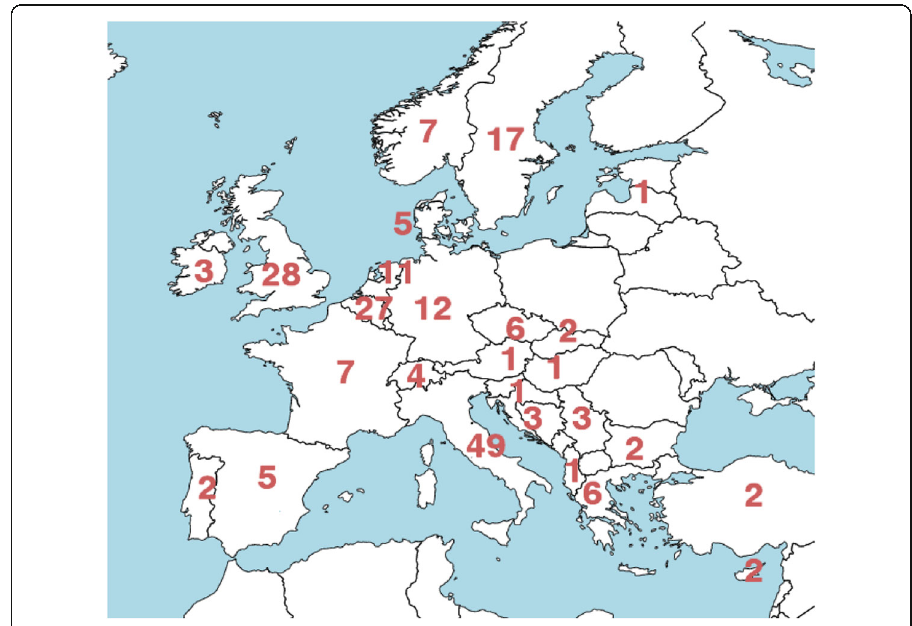
Fig. 1 Number of responding centers in different European countries. No responses were received from countries without